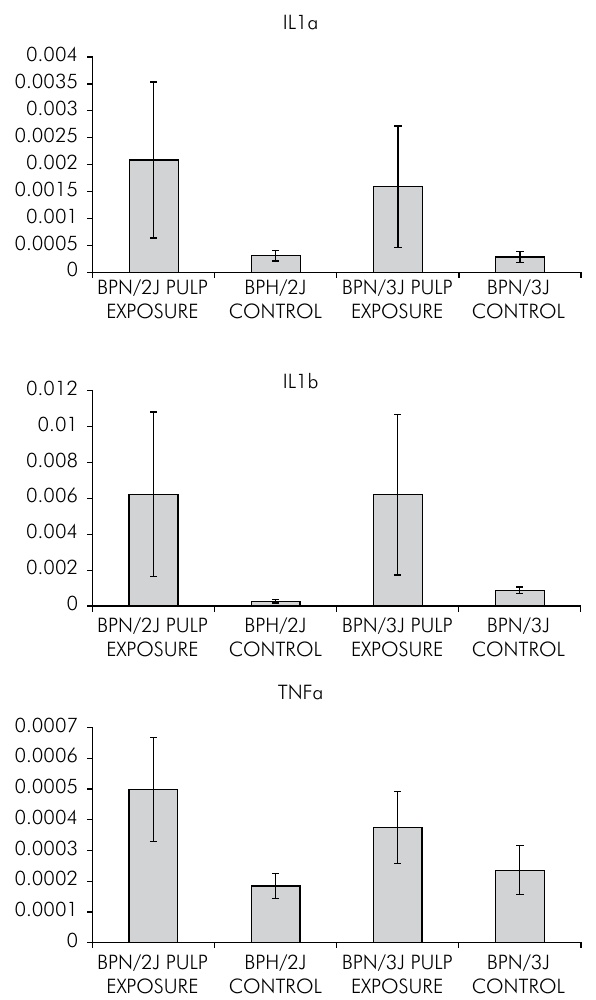
Figure 3. Averages of IL1 α , IL1 β and TNF α expressions. The value is in picograms of cytokines per milligram of periapical tissue. n = 5 for each group for each cytokine. No statistically significant difference was